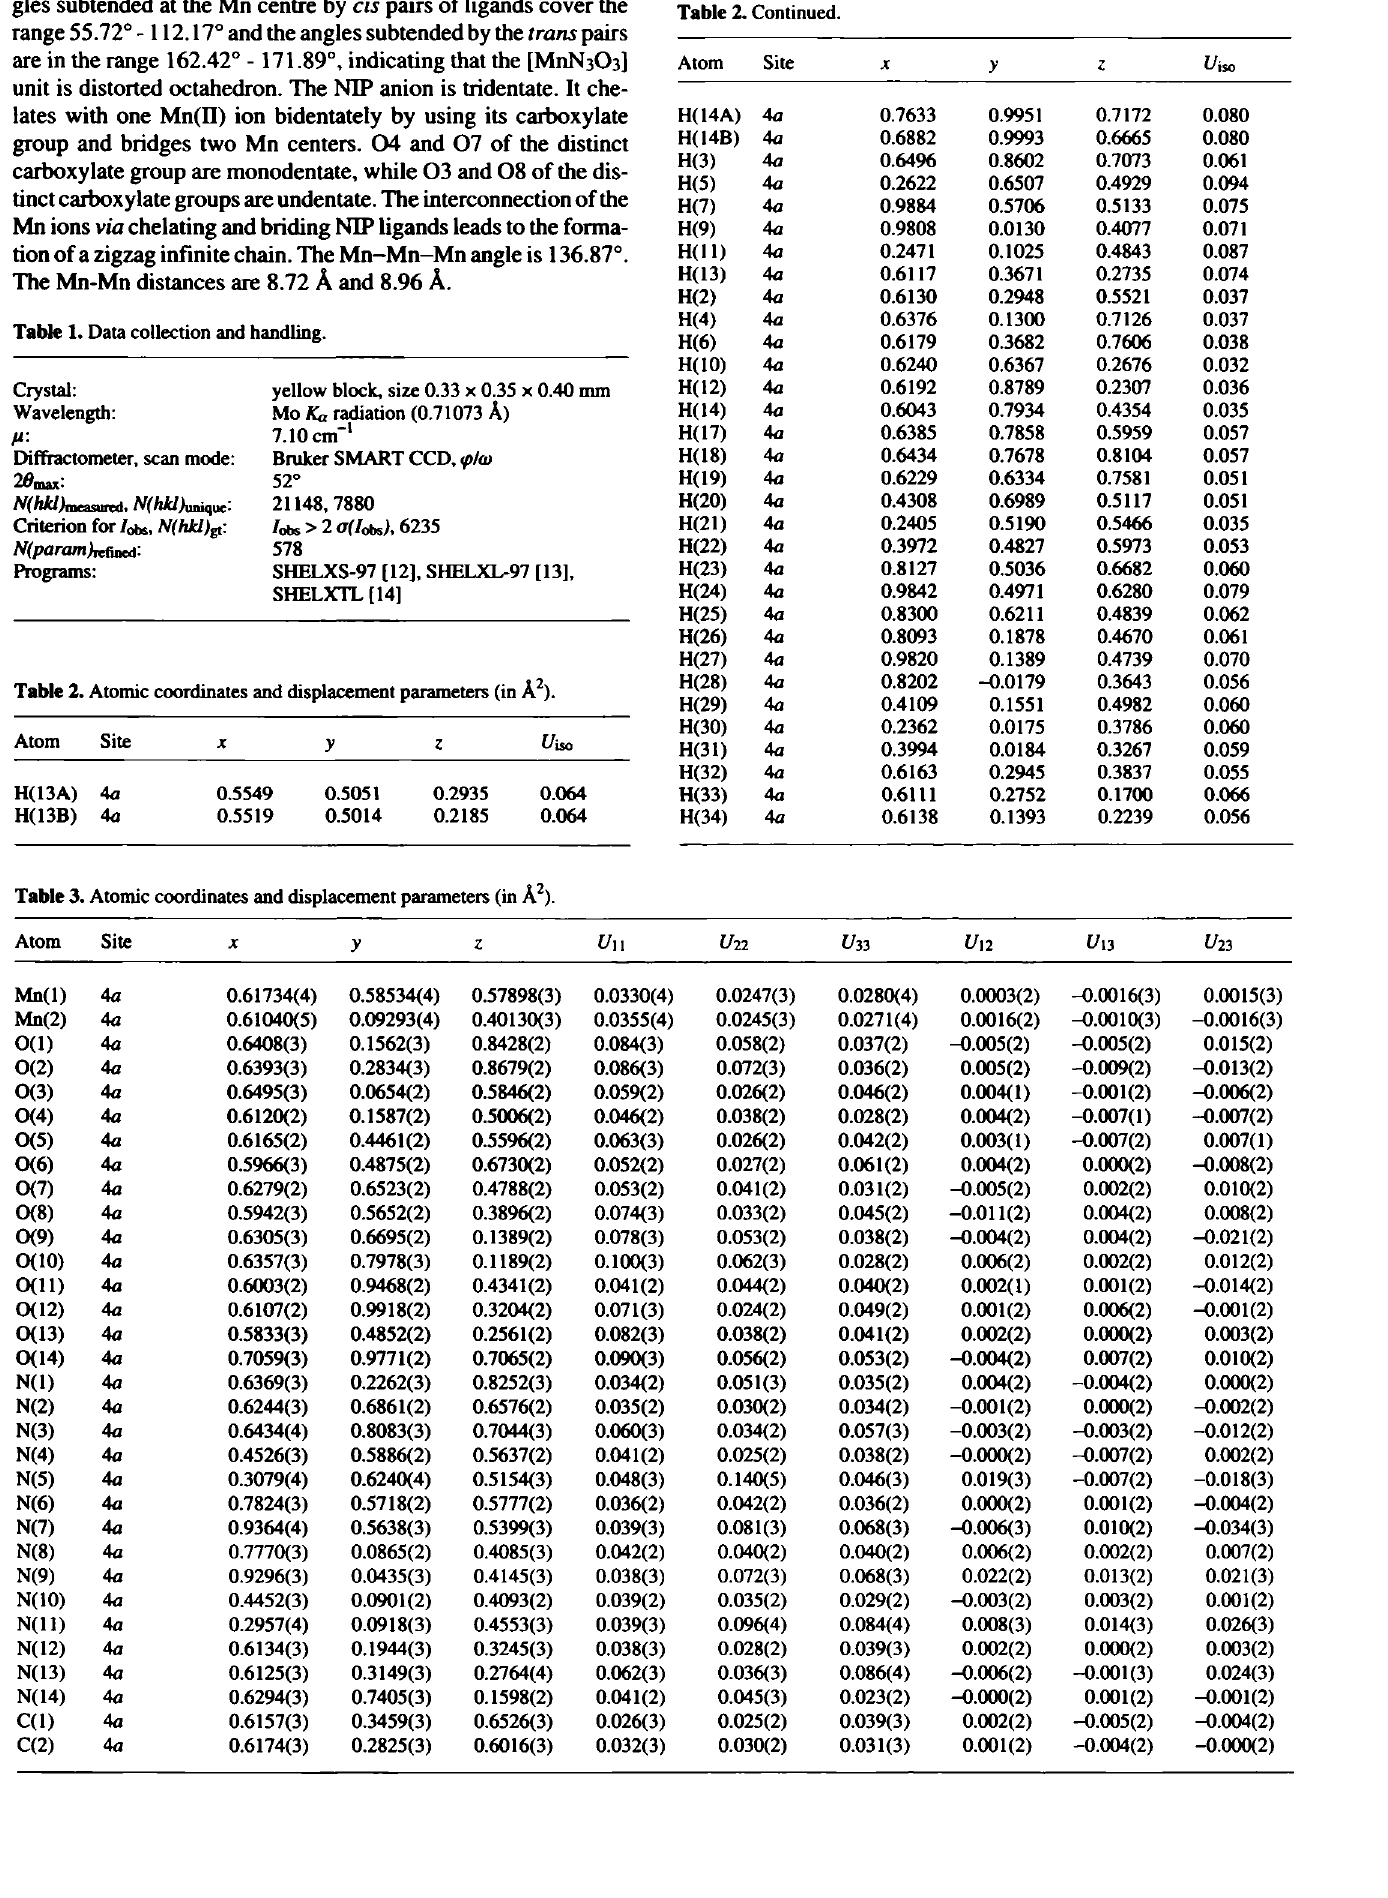
Table 2. Atomic coordinates and displacement parameters (in Â 2 ).